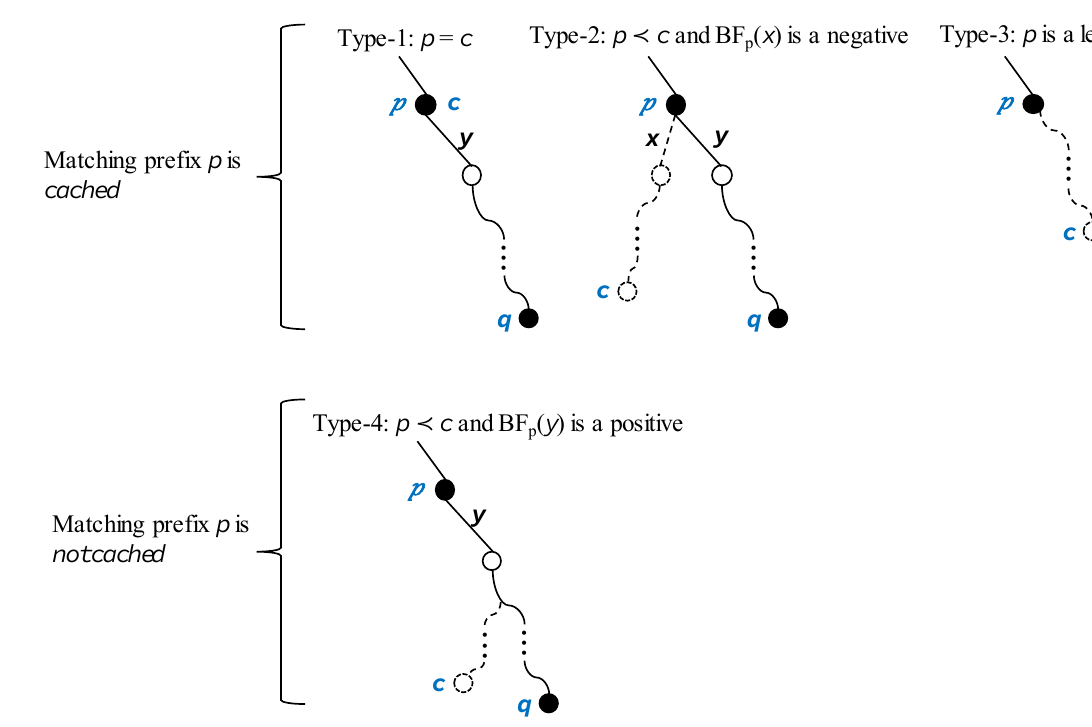
Figure 5. Type of matching prefix for a given name c .